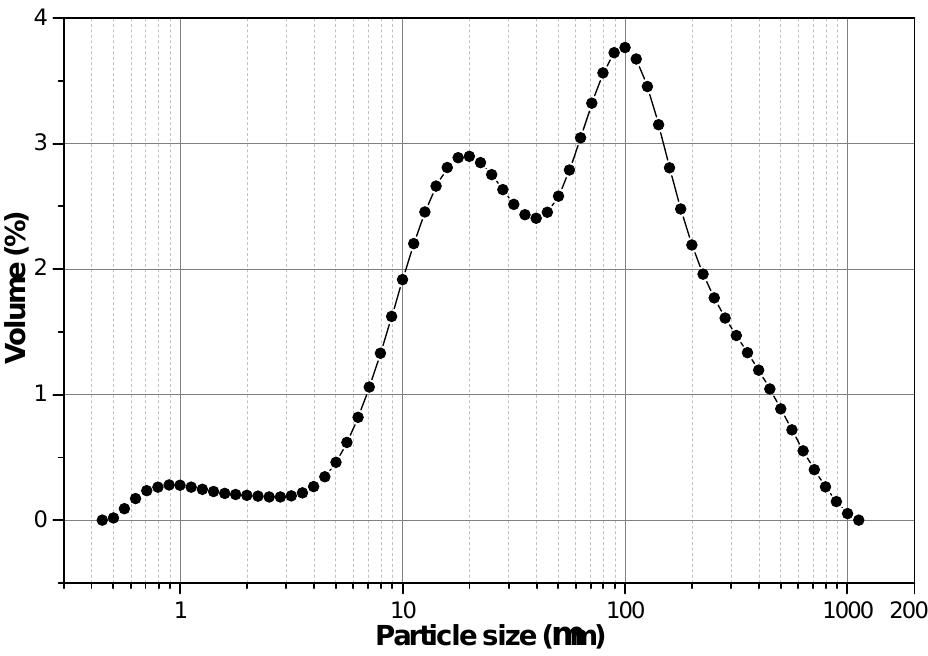
Figure 3. Particle size distribution of stone wool fiber by Laser Beam Diffraction (LRD).